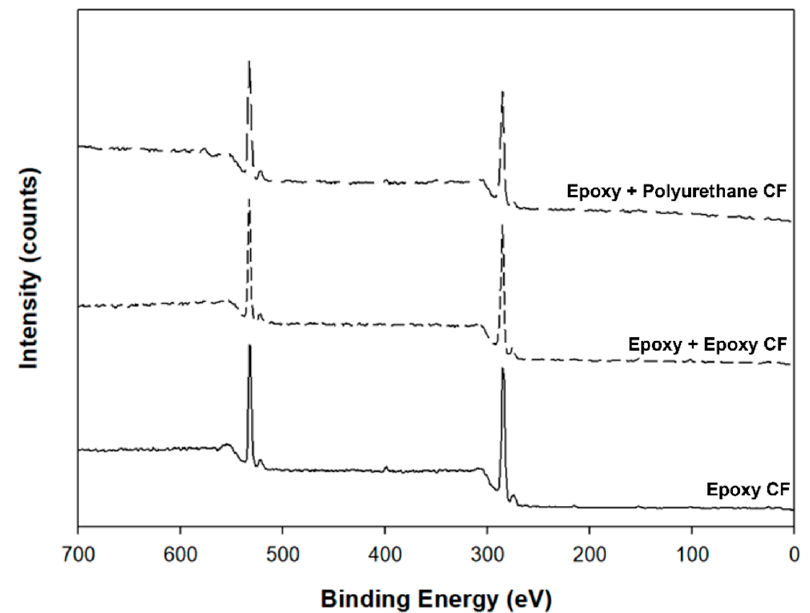
Figure 3. XPS survey scans of carbon fibers sized with epoxy, epoxy + epoxy, and epoxy + PU. Table 1. The atomic contents existing on the surfaces of (epoxy) single-sized and (epoxy + epoxy) and (epoxy + PU) dual-sized carbon fibers measured by XPS.